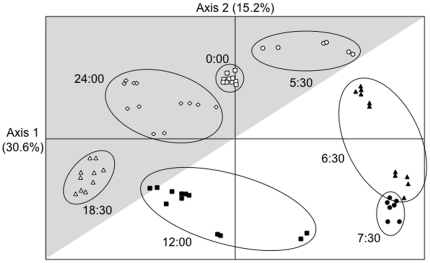
Principal component analysis performed on the transcript abundance values of the 4757 selected genes, estimated in all samples of the two independent experiments.The projection of the samples onto the two most informative axes (Axis 1 and 2) is shown and the inertia value of each axis is provided. At each sampling time, all replicates are represented by the same symbols and grouped in the same ellipse. The gray shaded part of the figure represents the dark period of the light/dark cycle.